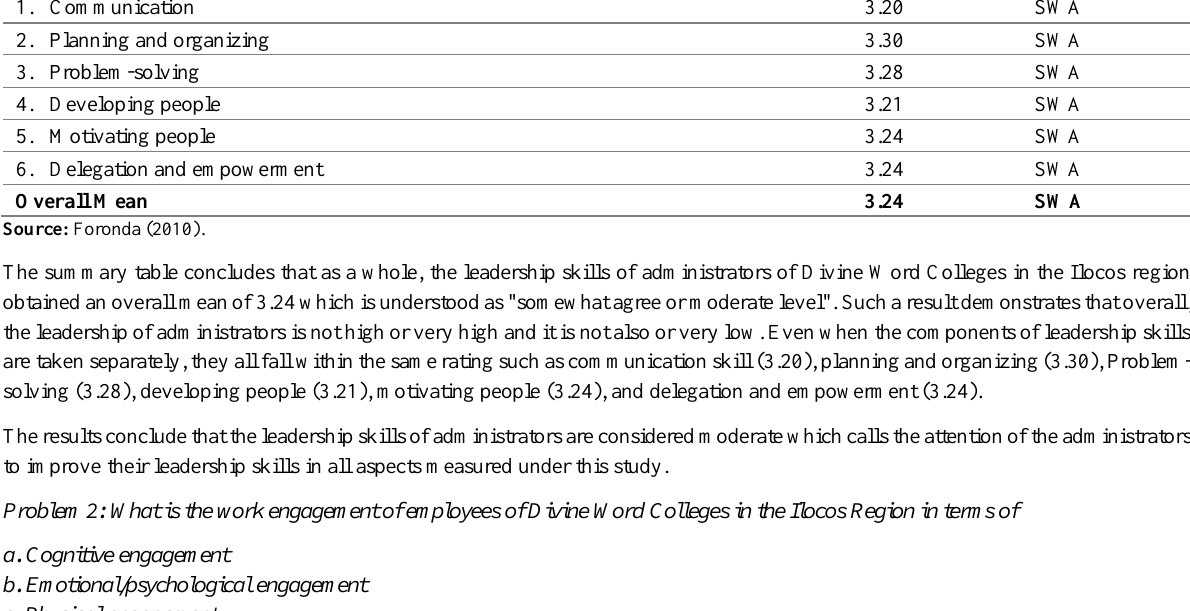
Table 7: Summary of Leadership Skills of Administrators of Divine Word Colleges in the Ilocos Region Indicators